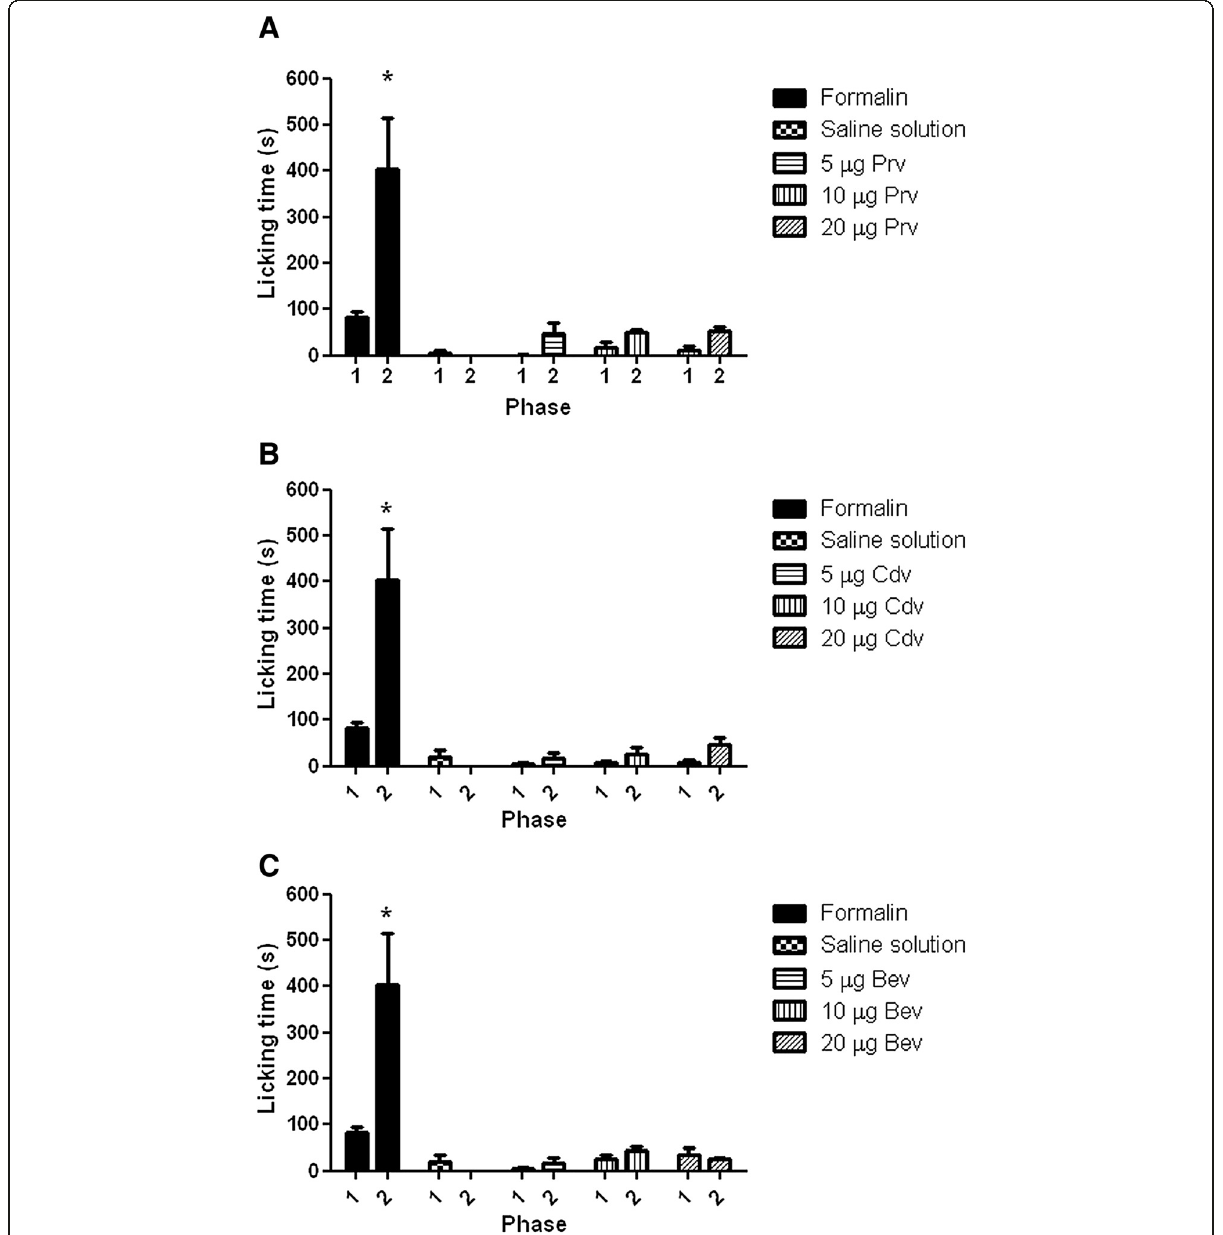
Fig. 2 Formalin test for assessment of the nociceptive activity in rats of a P. regalis , b C. darlingi , and c B. epicureanum venoms at three different doses (5, 10, and 20 μ g protein/paw). Nociceptive behavior in phase 1 (0 – 10 min post-injection) and phase 2 (10 – 50 min post-injection) was scored as the amount of time spent licking the injected paw. *Significant difference when compared with the negative control injected with saline solution ( p